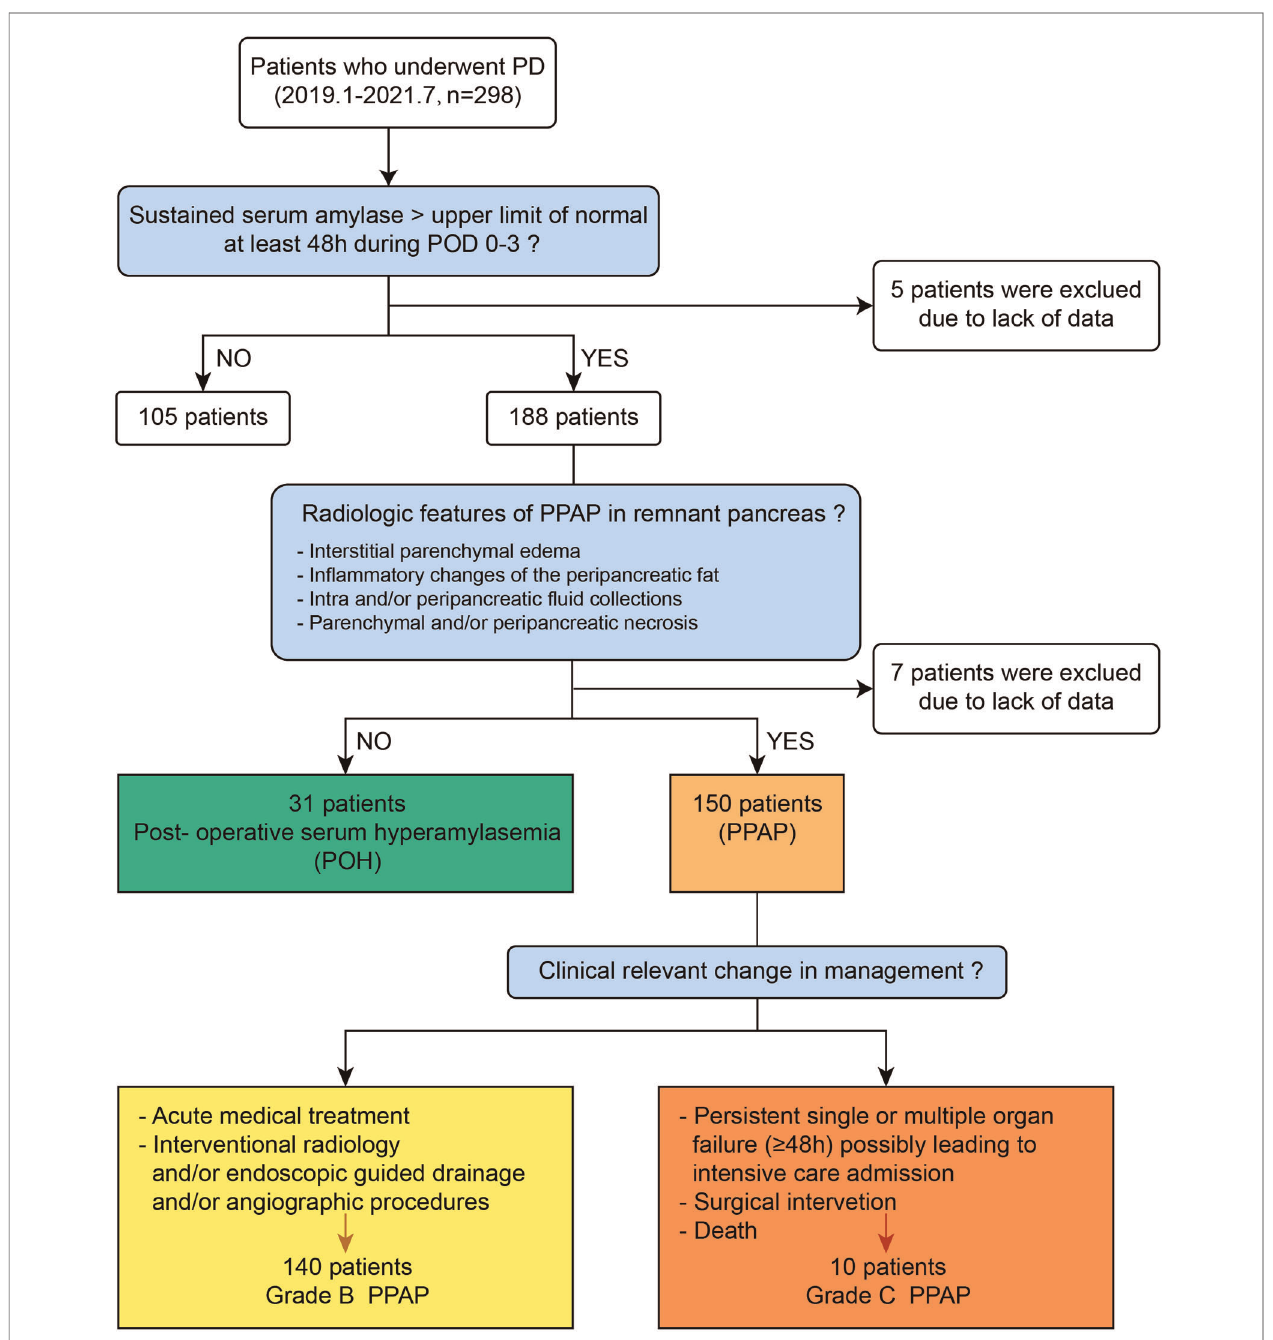
FIGURE 2 | Diagnostic fl ow chart of PPAP based on the diagnostic criteria of